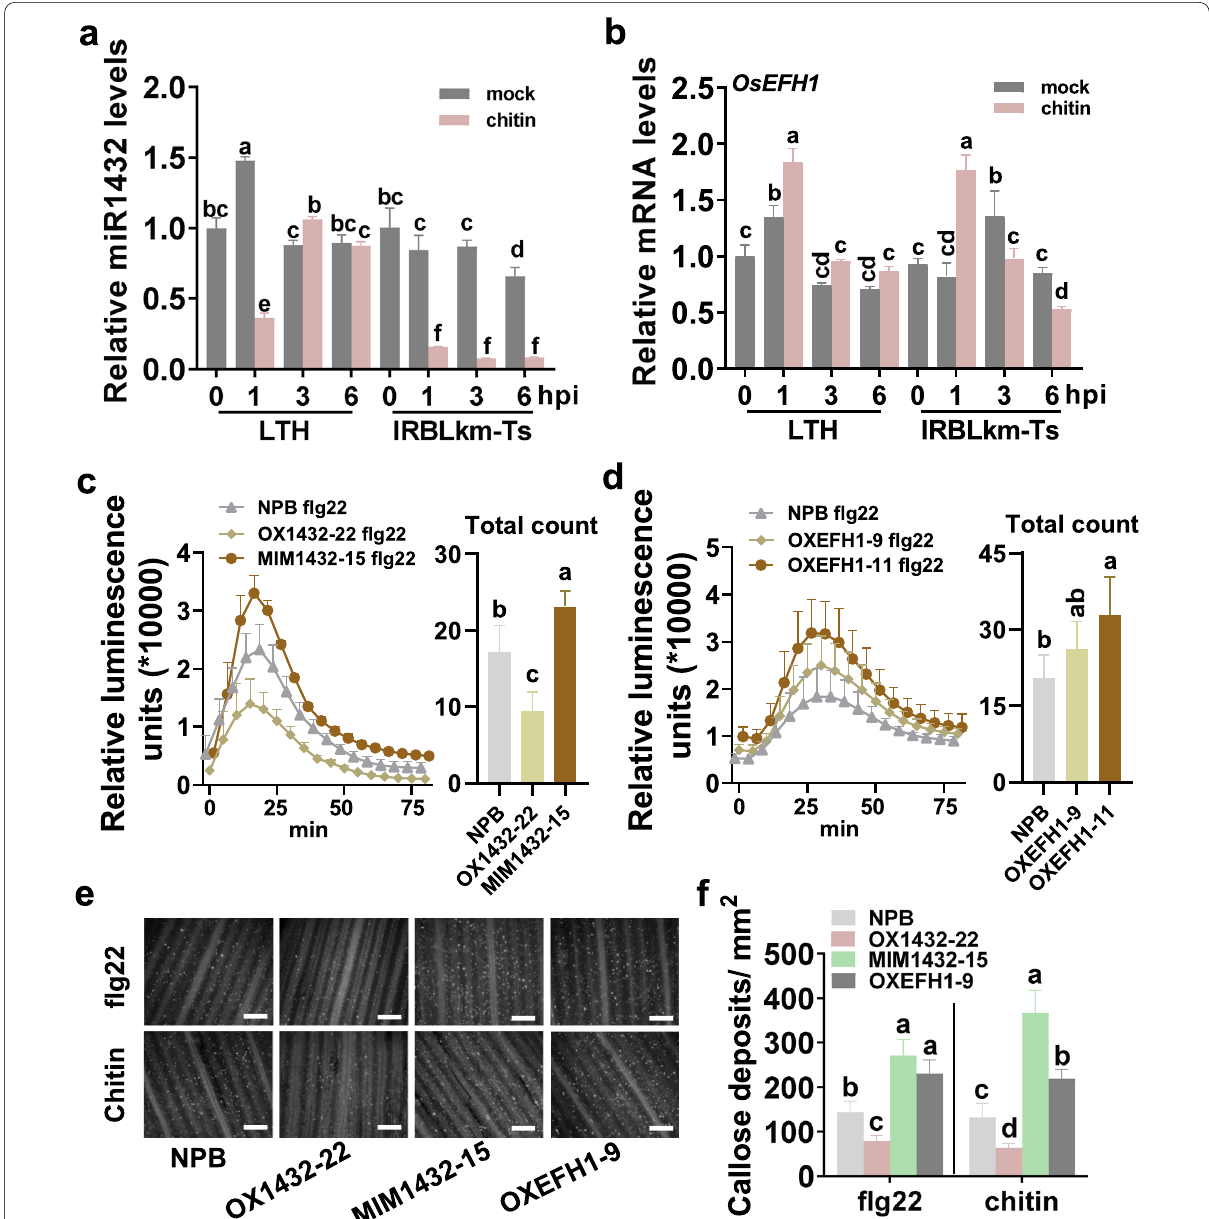
Fig. 5 miR1432‑ OsEFH1 module regulates rice PTI responses. a , b The reverse transcription‑quantitative polymerase chain reaction (RT‑qPCR) data show the amounts of miR1432 (a) and the mRNA levels of OsEFH1 (b) in LTH and IRBLkm‑Ts with or without chitin treatment. Data are shown as mean SD (n 3 independent samples). c , d The burst of reactive oxidative species (ROS) induced by flg22 in the leaves of indicated lines and ± = the Nipponbare control, respectively. Data are shown as mean SD (n 4 independent repeats). The left diagrams show the relative ROS levels at ± = each timepoint, the right diagrams show the total ROS count. e PAMPs (flg22 and chitin) induced callose deposition in the leaves of indicated lines and the Nipponbare control. Bar 0.5 mm. f Quantitative analysis of PAMPs‑induced callose deposition in e . Data are shown as mean = independent repeats). For a, b, c, d, and f, different letters above the bars show significant differences ( P < 0.01) as determined by the One‑way Tukey–Kramer test. These experiments were repeated two times with similar